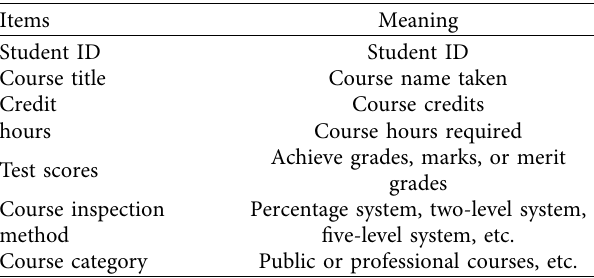
Table 3: Student grade fields and their meanings.